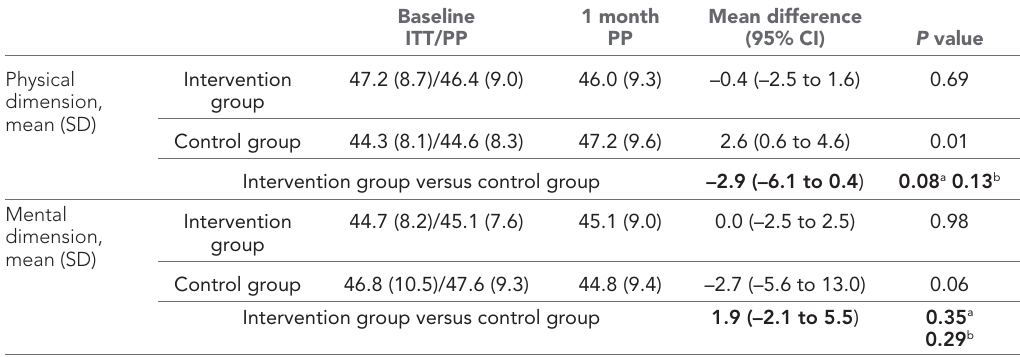
Table 3 SF- 12 scores at baseline and at month one after the consultation in the intervention and control groups